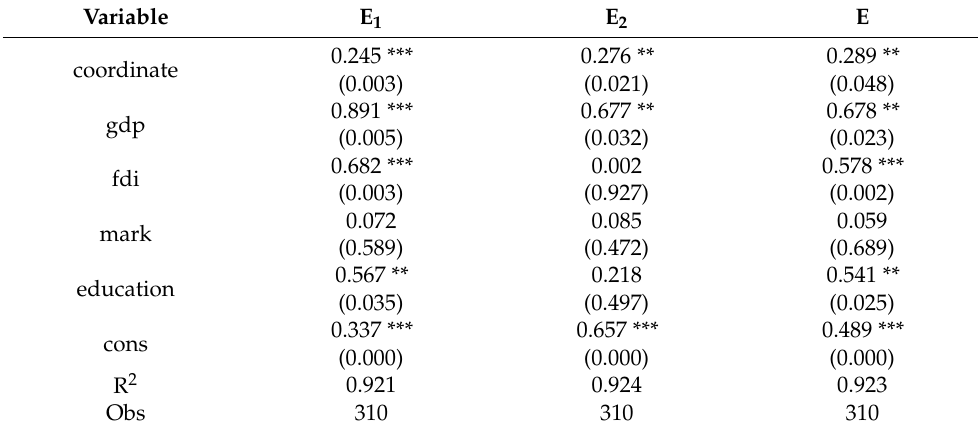
Table 3. Overall analysis.